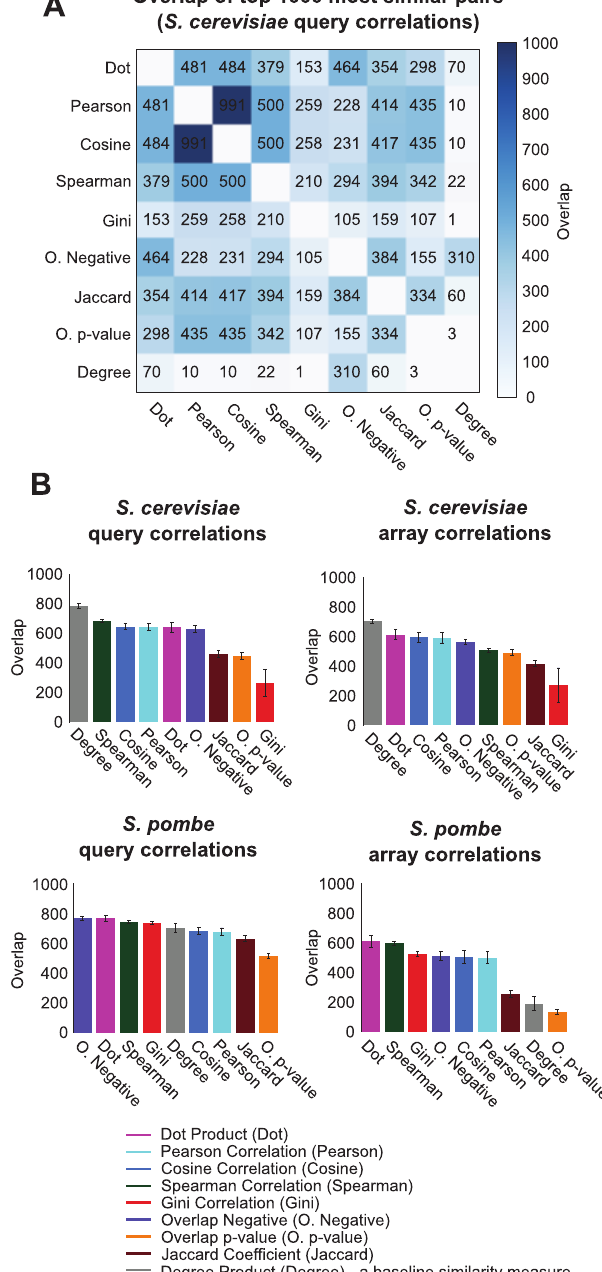
Figure 2. Comparison of similarity measures based on highly similar gene pairs and stability on partial data. (A) The overlap of the top 1000 similar gene pairs for each similarity measure were compared against each other on the query gene side of the S. cerevisiae genetic interaction data (B) The stability of the similarity measures was assessed by comparing the overlap of top 1000 similar gene pairs computed using 10 different random selections of 50% of the data in each